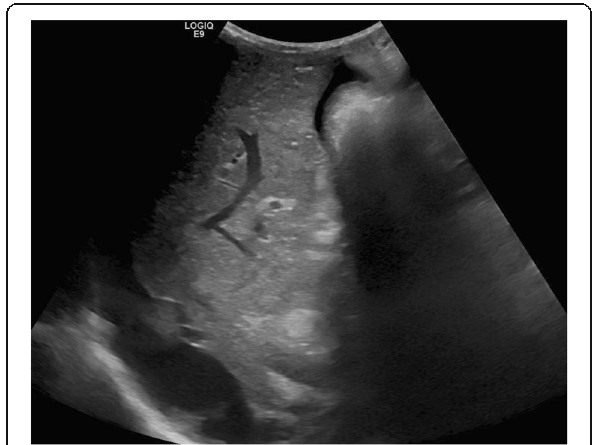
Fig. 2 Liver cirrhosis in pediatric Gaucher disease. Sagittal grayscale ultrasound demonstrates an enlarged liver with nodular cirrhotic morphology and perihepatic ascites in a 12-year-old male with